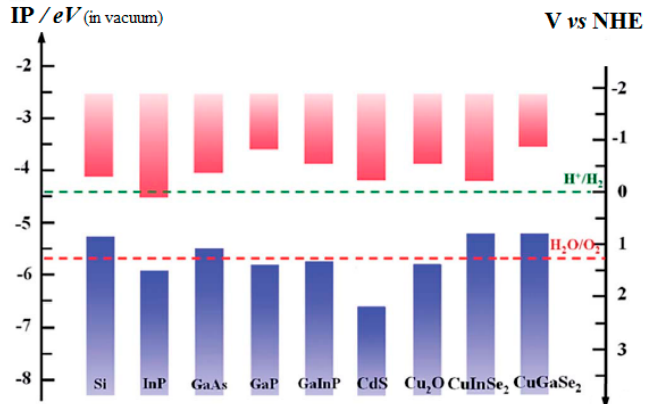
Figure 16. Positions of the band edges for some p ‐ type semicondutors relative to the thermodynamic levels for water splitting. IP is the ionization potential energy evaluated with respect to the vacuum level. Adapted from reference [119].